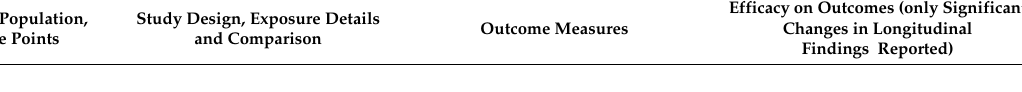
Table 2. Summary of included study characteristics and longitudinal